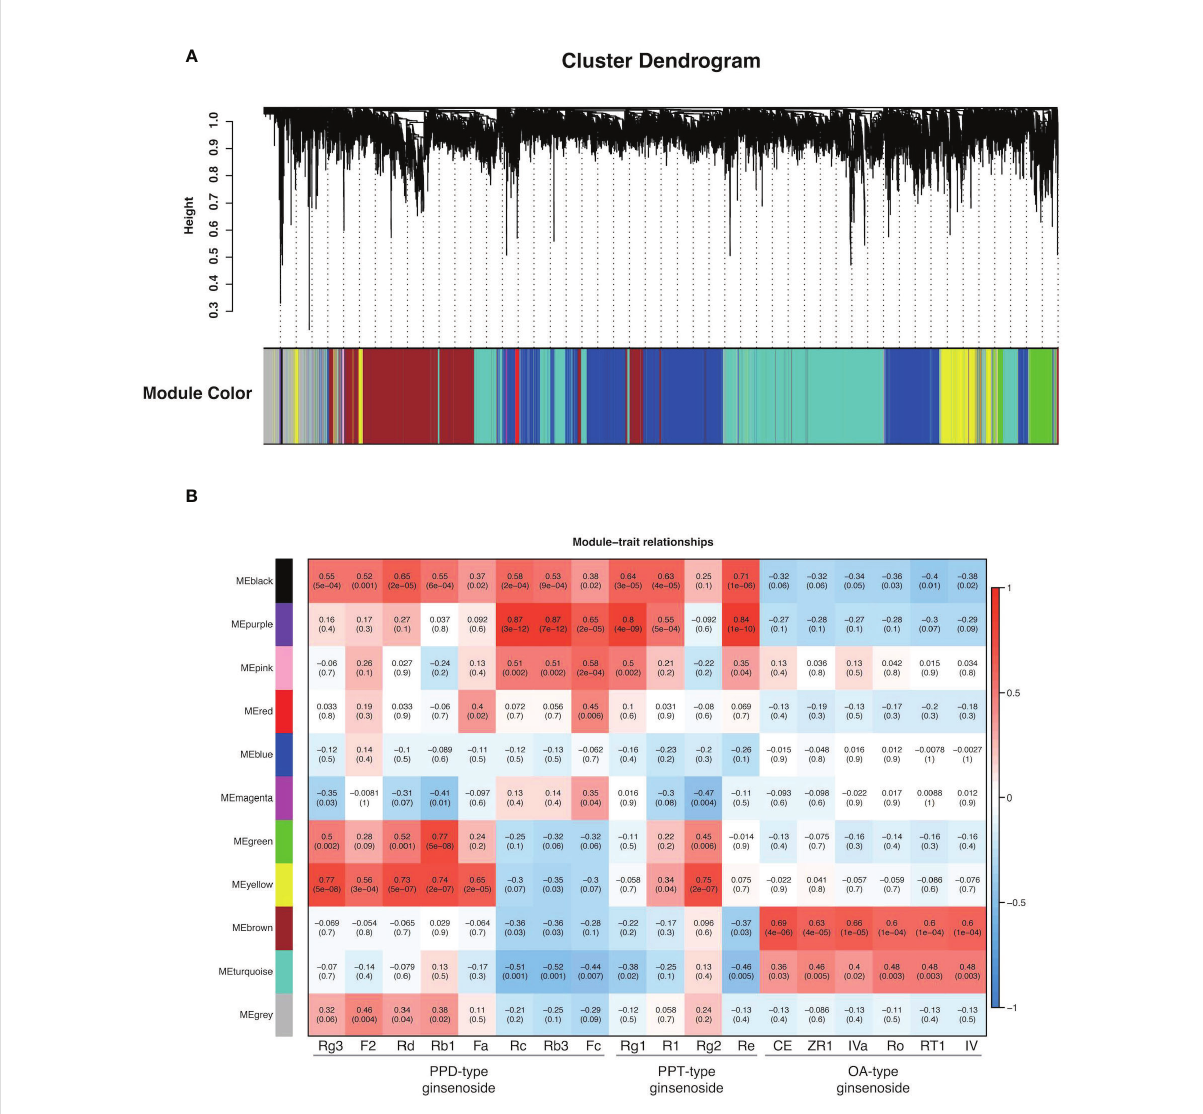
FIGURE 6 WGCNA of 17,885 genes with ginsenoside content data. (A) The hierarchical cluster tree indicates the co-expression modules identi fi ed by WGCNA. Each leaf in the tree represents one gene, and major branches labeled with different colors constitute 11 modules. (B) Module − content correlations. The correlation coef fi cient between the module and sample is described by the color of each cell at the row − column intersection, and the color scale on the right shows module-trait correlation from -1 (blue) to 1 (red). Numbers within cells represent correlations and p - values (in